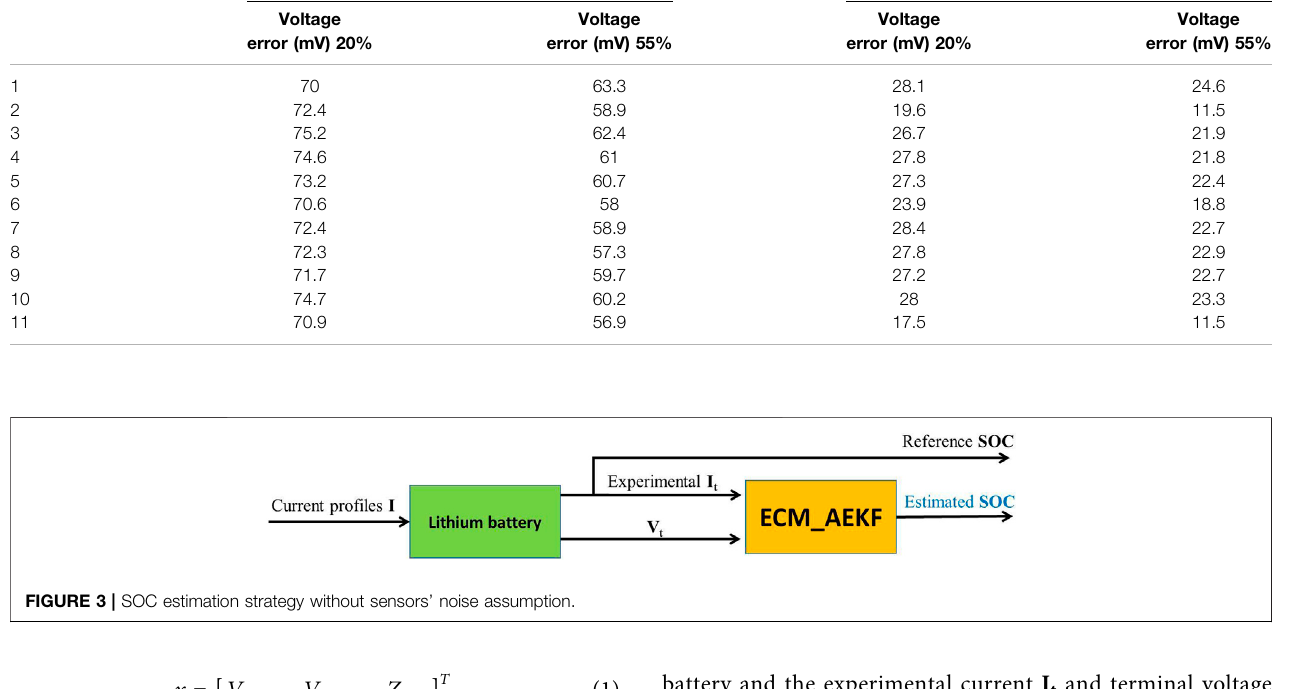
TABLE 1 | Voltage error between Method A and Method B. Cell no.